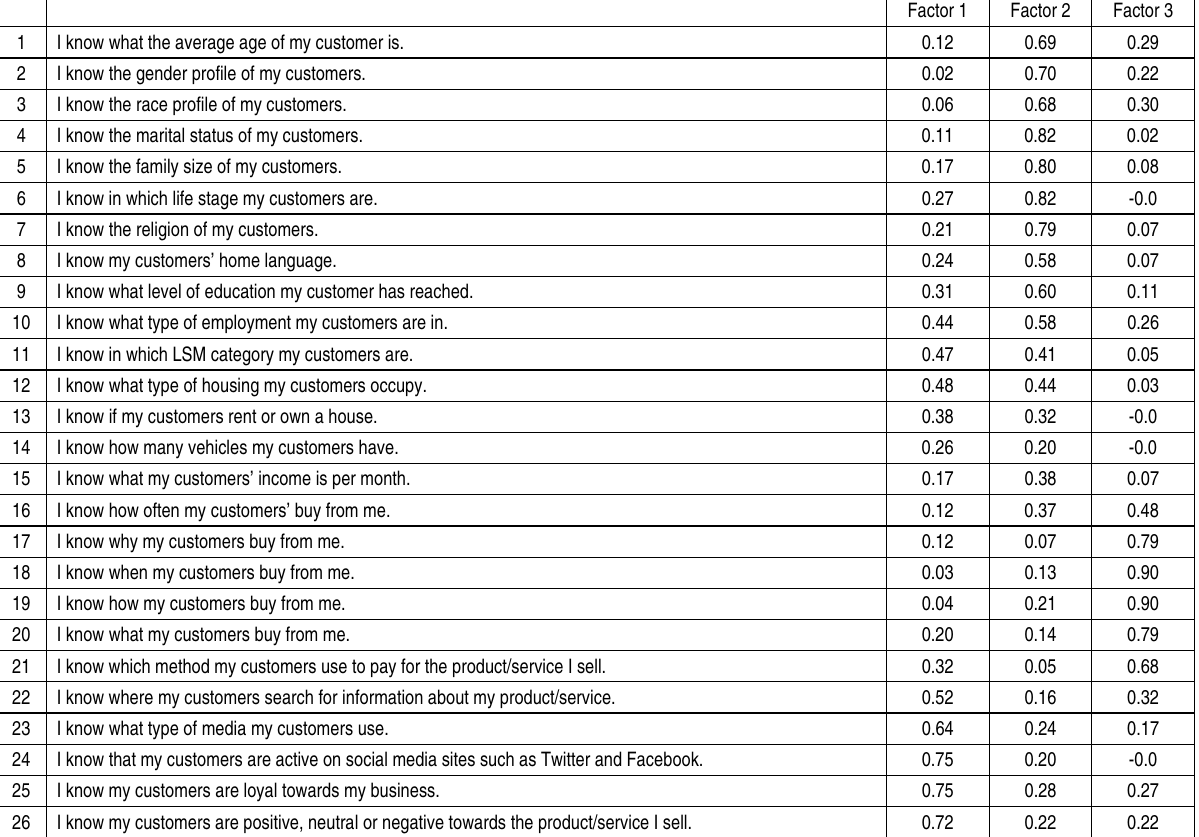
Table 2. Factor loadings for the rotated